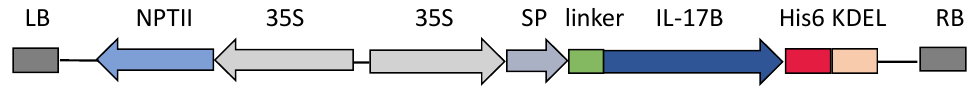
Figure 6. Molecular validation of transgenic lines with 17B specific primers. M: DNA mark, 1~22: transgenic lines, W: wild plant as negative control, P: p2301-17B plasmid as positive control. Figure 7. Western blot detection of recombinant protein from transgenic duckweed plants. ( A ) Western blot analysis of various concentrations of standard 17B purified from E. coli . ( B ) Western blot analysis of protein samples from plants. M: protein mark, 1 – 7: transgenic lines, 8: the standard protein (400 ng/mL), 9: wild plant. To assess the bioactivity of IL-17B expressed in duckweed, we purified the recombi- nant protein and performed the following in vitro experiments. The purified protein was incubated with DF-1 cells after 4 h to analyze the expression of immunoadjuvant-related genes including MyD88, NF-kB, IFN- γ, IL -1 β, JAK2, and IL -4. In the NF-kB pathway, the expression of MyD88 and NF-kB were significantly higher than those in the control group (Figure 8). In addition, IL-17B stimulated the expression of cytokines (IFN- γ, IL -1 β and IL-4) and caused significant upregulation of JAK2 in DF-1 cells.